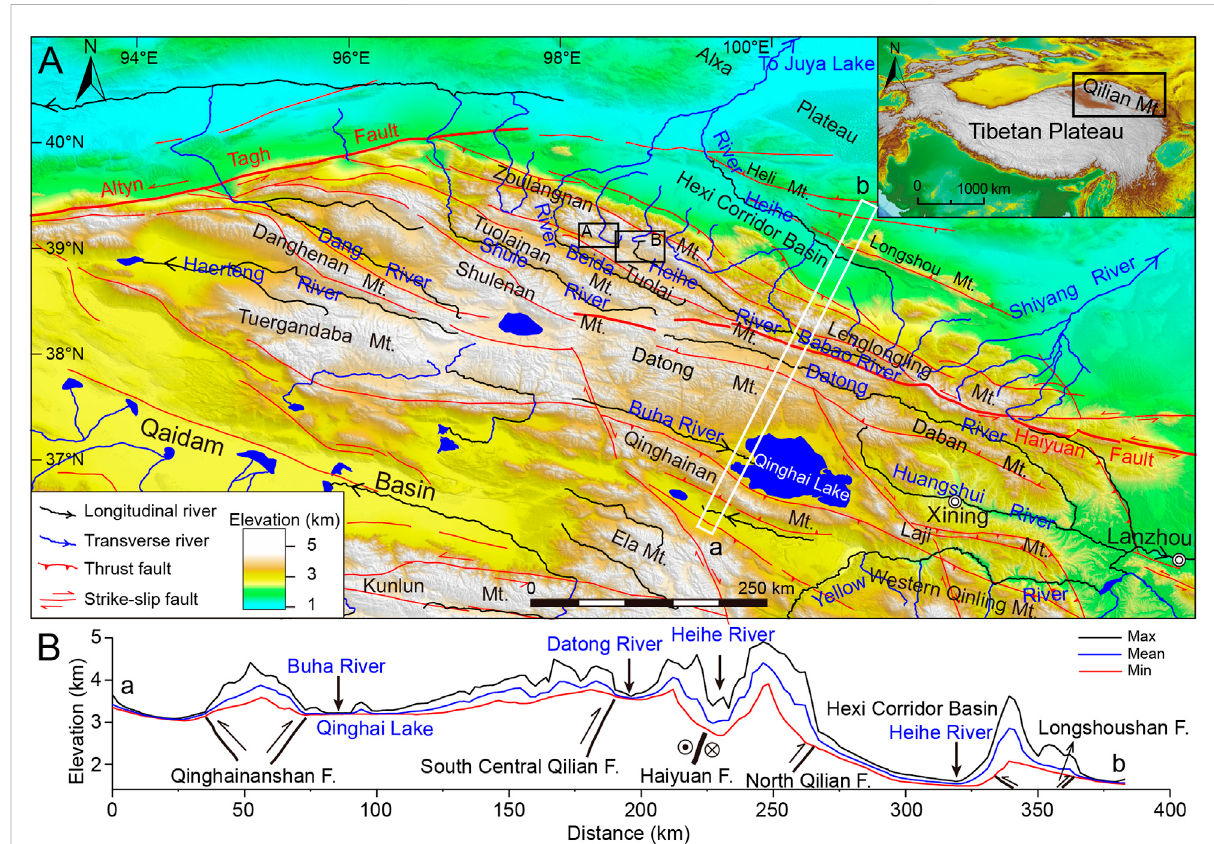
FIGURE 1 (A) : Geomorphological and geological characteristics of the Qilian Mountains. The black box in the inset shows the location of the Qilian Mountains in Figure 1A. The A and B black boxes show the locations indicated in Figures 6A,C, respectively. The white box shows the location of the topographic swath pro fi le shown in (B) . Locations of major faults are from Deng et al., 2003. (B) : Maximum, mean and minimum elevations along a 20 km wide swath window. The swath shows the major topographical and geological features across the Qilian